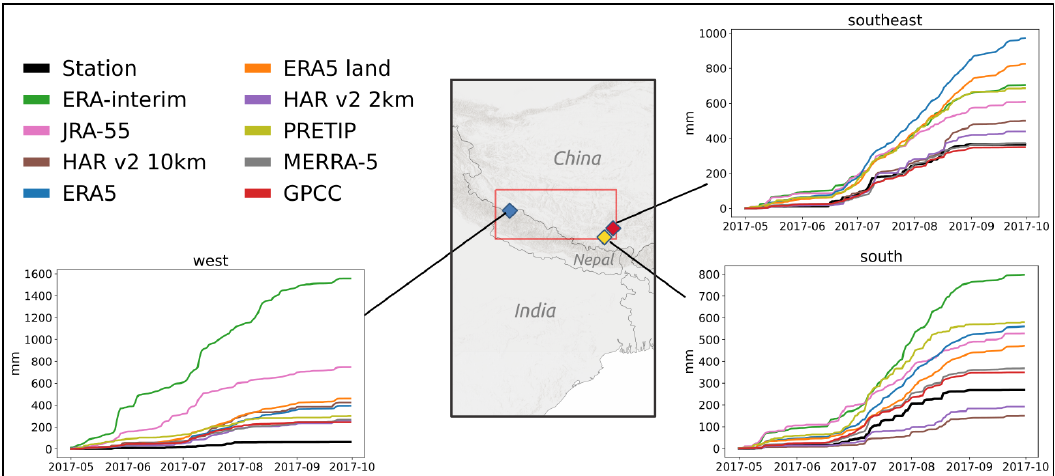
Figure 6. Cumulative sum of daily precipitation throughout the study period for the station data (black line) and the gridded precipitation products (colored